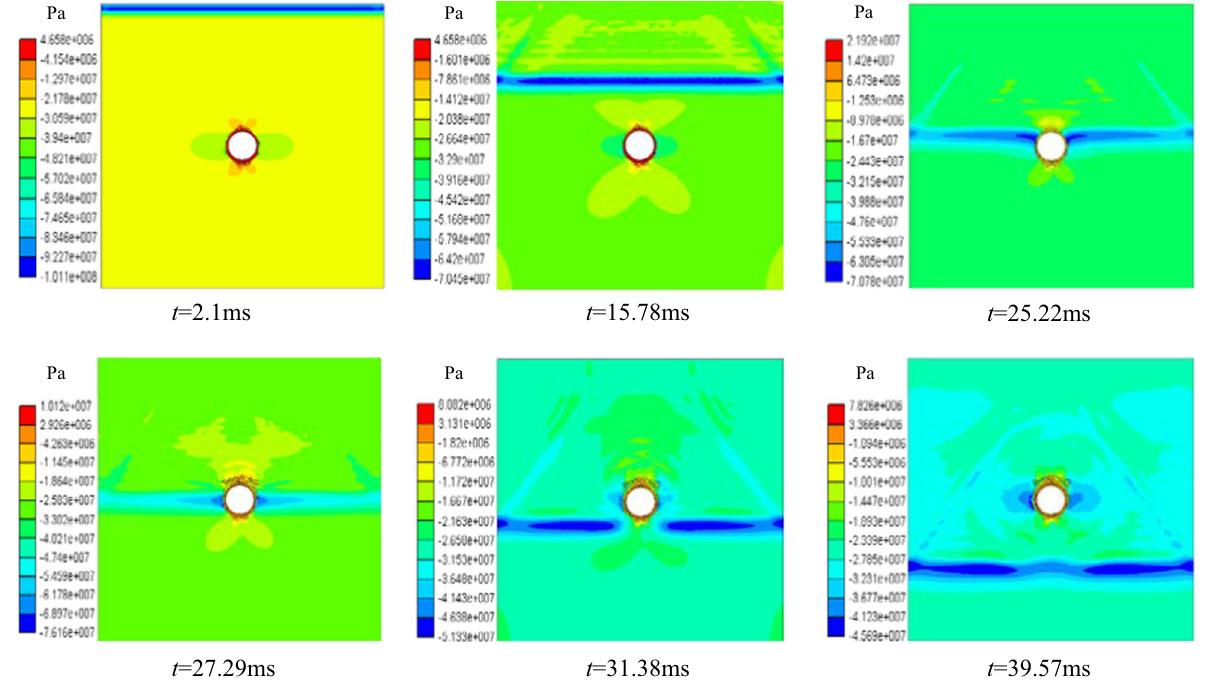
Fig. 6 Dynamic stress-wave propagation process in the numerical model. Note: The dynamic stress-wave was imposed on top domain, and the amplitude is 80 MPa. The initial time starts from 2.5